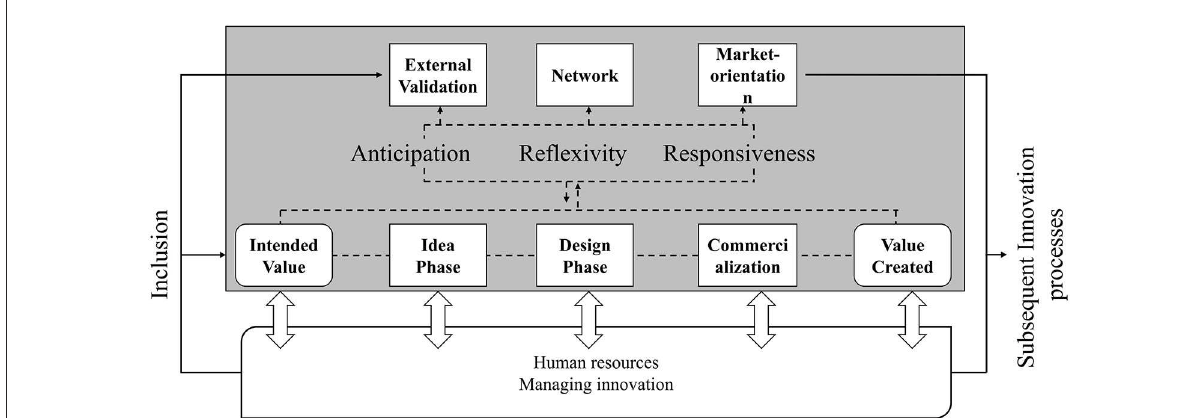
FIGURE2 Assessment of responsible management in the innovation process for sustainability own assessment adapted from Keskin et al. (2013, p. 55). Based on the innovation process of Keskin et al. (2013). External validation, network and market-orientation are essential components that are influenced by responsible management of the innovation process. They also influence the management as a source of knowledge based on which the innovation process responds. The dashed line reflects the normative character of RRI. The RRI principles accompanies the entire process. Inclusion has a direct influence on further activities in the innovation process. The extent and variety of inclusion determine the results that emerge from anticipation and thus what is ultimately reflected and responded to. The transfer of knowledge gained to subsequent processes is determined by responsiveness, which requires that the experiences from previous processes are transferred to subsequent processes. The continuous line represents the continuation of experience in subsequent processes as part of the current innovation